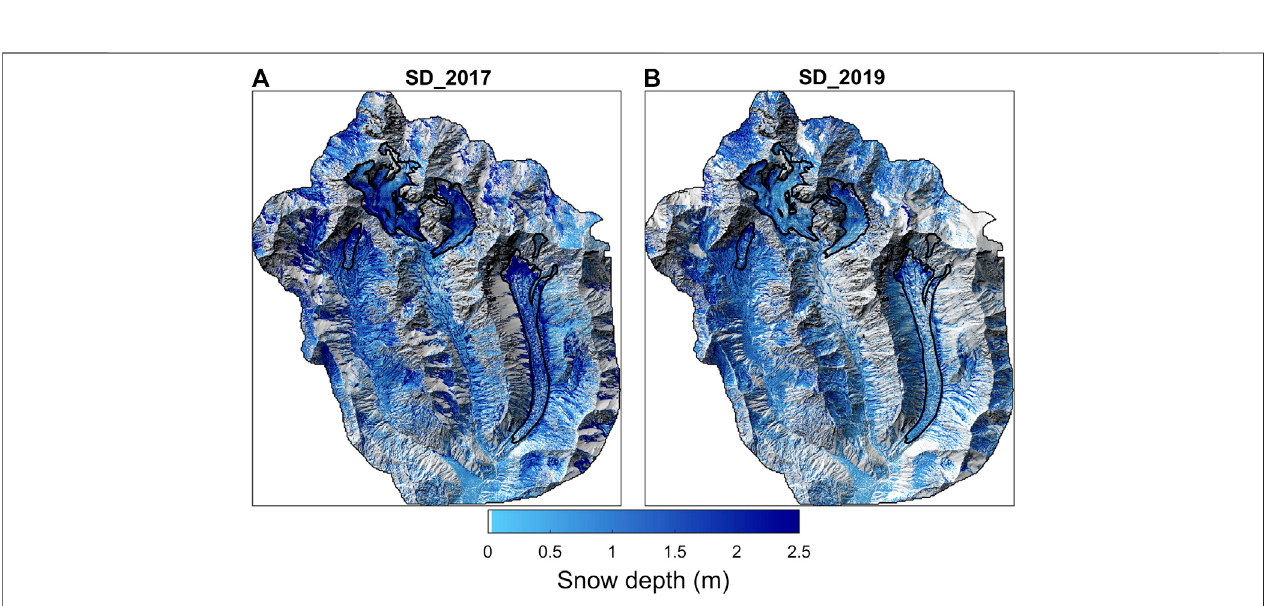
FIGURE6| Thespatialsnowdepthmapsfor2017 (A) and2019 (B) ,withaxeslimitedto0 – 2.5 mforclarityinthesmallerdepthvalues.Withtheexceptionofglacier areas (see text for explanation), snow depths were derived from digital elevation model (DEM) differencing of both September “ SnowON ” DEMs with the reference SnowOFF_2018